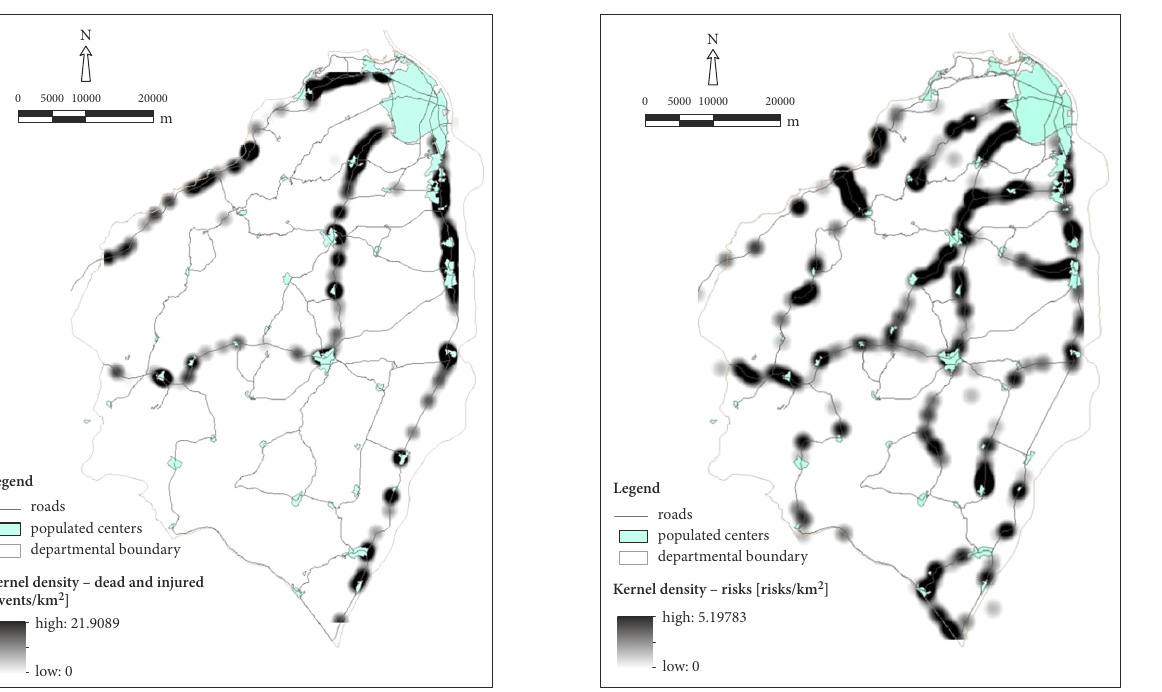
Figure 8. Spatial distribution kernel of FWI Figure 9. Density of risks by kernel